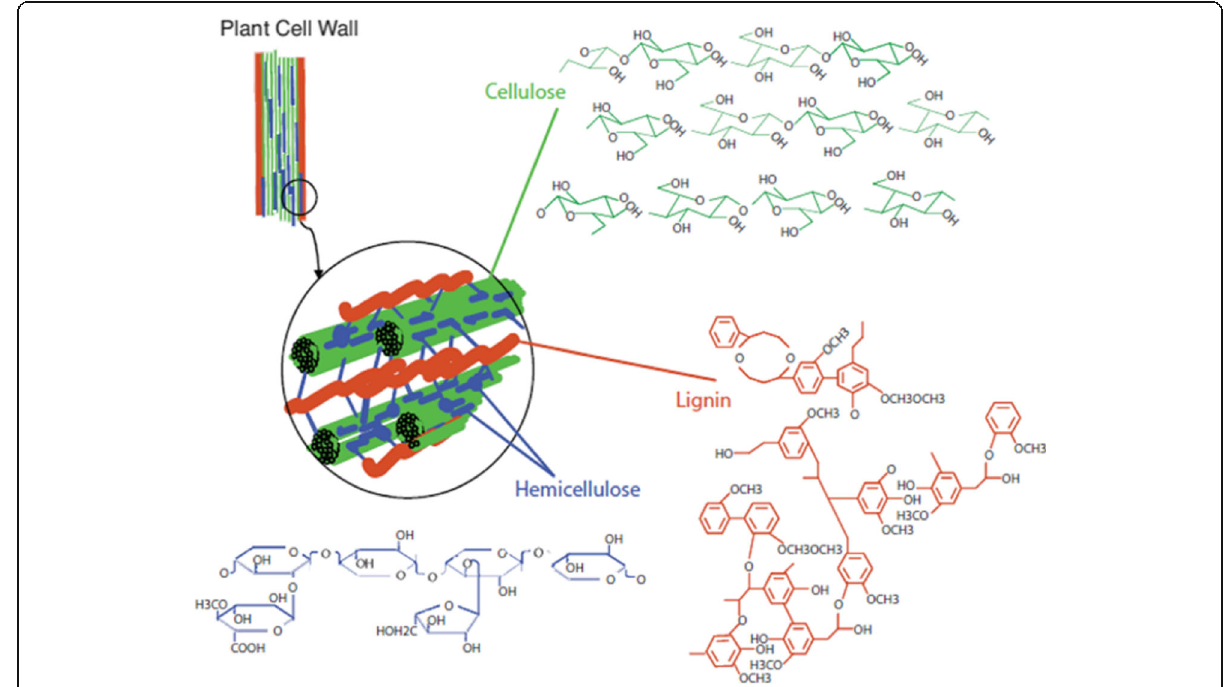
Fig. 1 Hierarchical structure of lignocellulosic